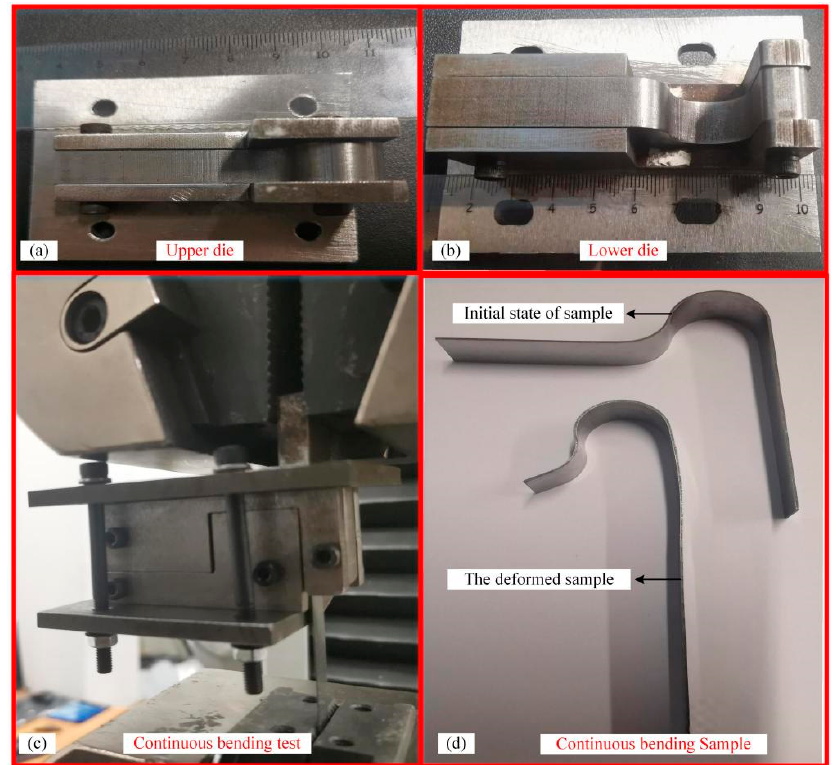
Figure 13. ( a ) Upper die; ( b ) Lower die; ( c ) Continuous bending test die; ( d ) Continuous bending Sample.